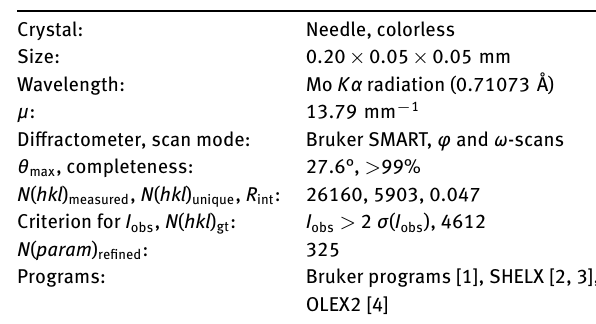
Table 1: Data collection and